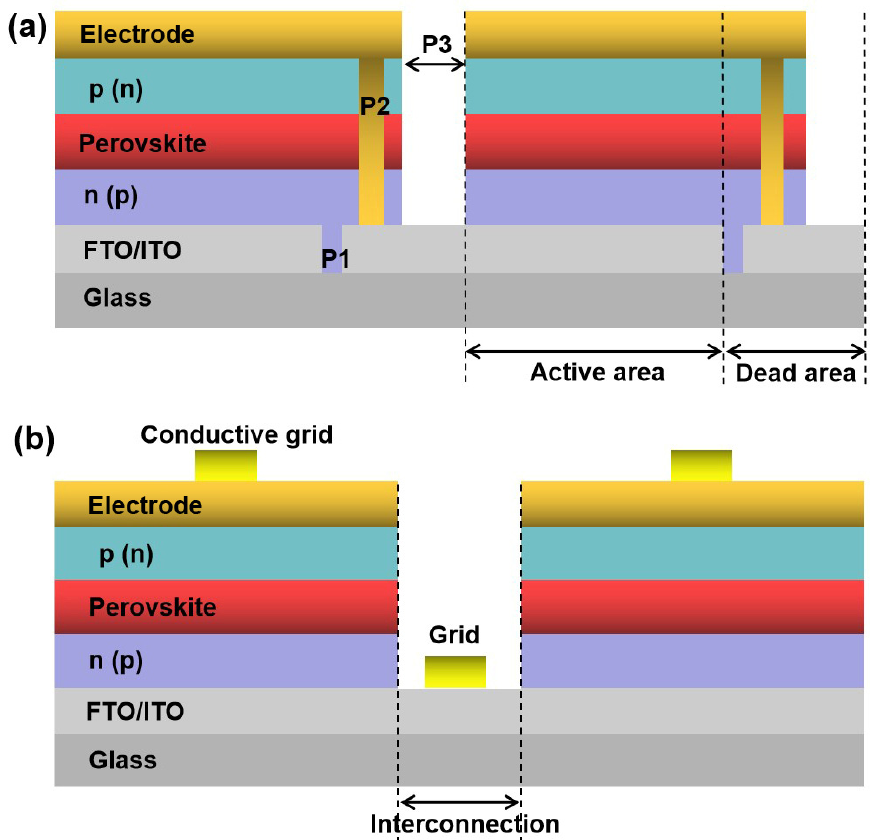
Figure 13. Cross-sectional schematic diagrams of grid lines. The sub-cells are connected in series ( a ) or parallel ( b ) [79]. (Reproduced from Ref. [79], 10.26599/NRE.2022.9120024, under the terms of the CC BY [4.0]